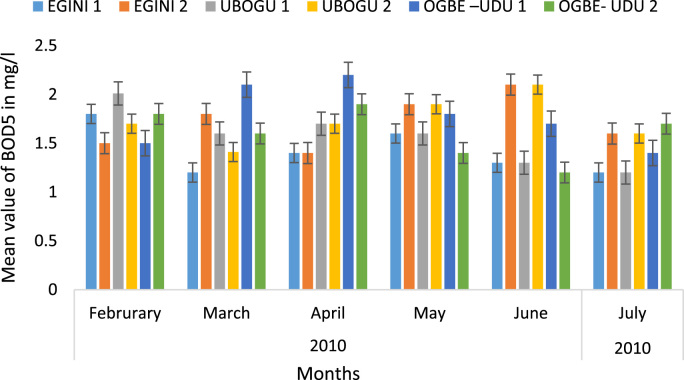
Mean Temporal and spatial variations in BODs.